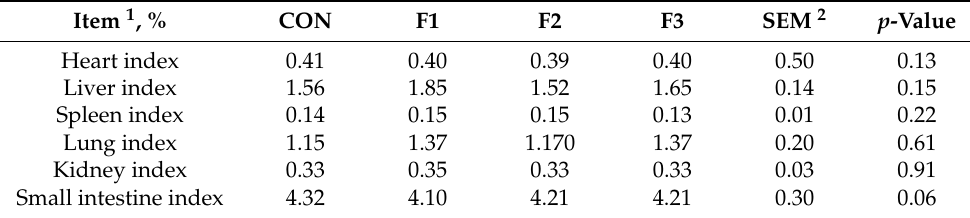
Table 3. Effects of fucoidan administration on organ index in weaned